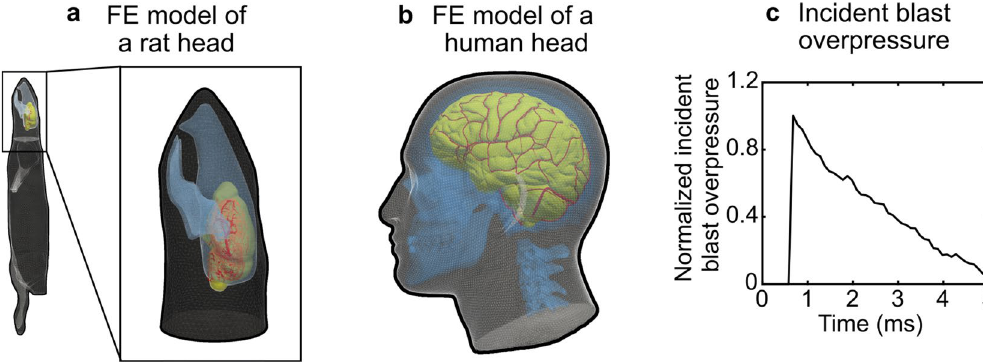
Figure 2. Representation of the previously validated high-fidelity, three-dimensional finite-element (FE) model of ( a ) a rat head 27,30 and ( b ) a human head 28 used in the blast simulations. ( c ) Normalized pressure–time